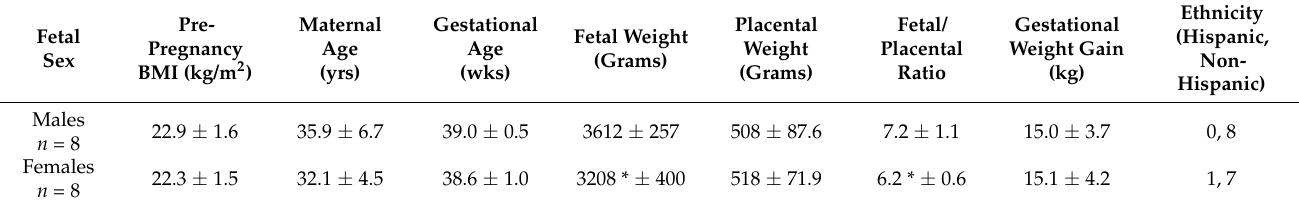
Table 1. Clinical characteristics of study participants.